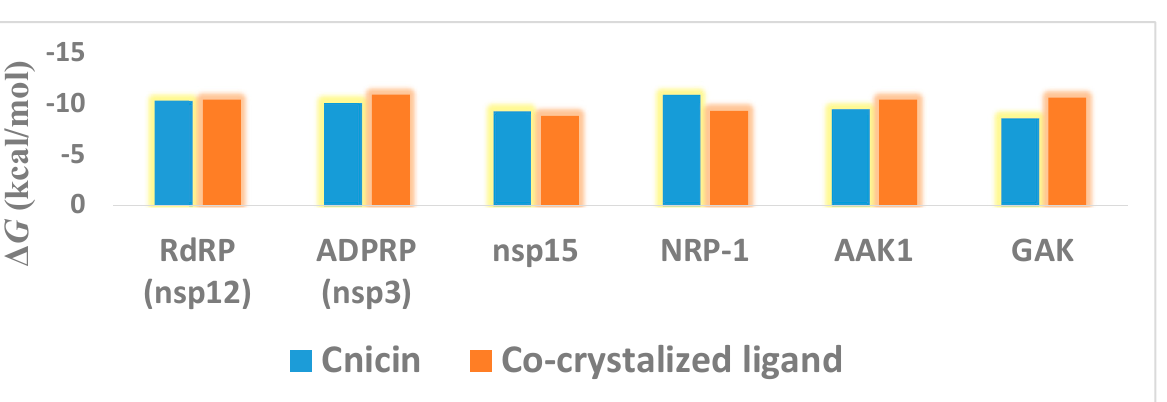
Figure 6. Binding free energies of cnicin inside its target proteins in comparison with the co-crystalized ligand of each protein.